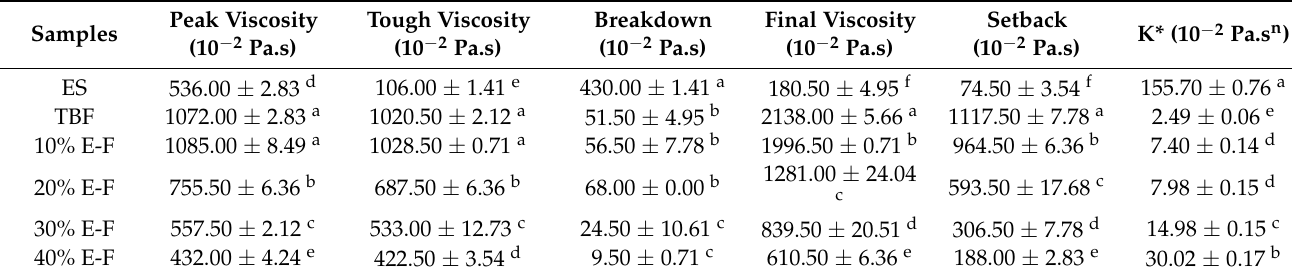
ES and TBF represent the extruded starch and Tartary buckwheat flour. The 10% E-F, 20% E-F, 30% E-F, and 40% E-F represent that the addition of extruded starch in the blended flour was 10%, 20%, 30%, and 40%, respectively. Means followed by the different letters in each column were statistically different ( p <